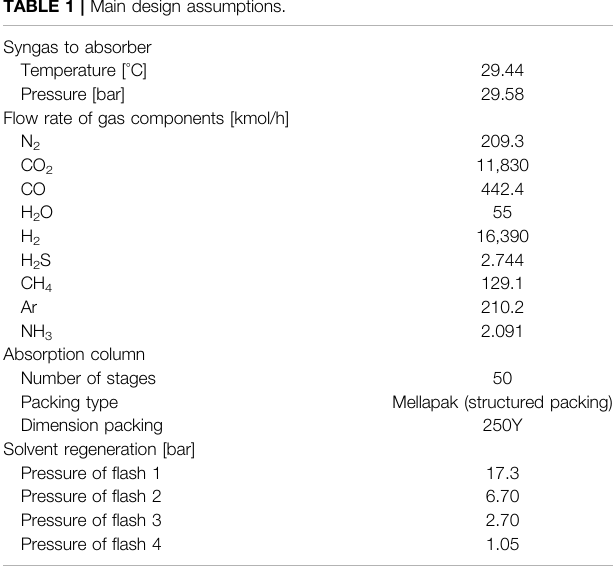
TABLE 1 | Main design